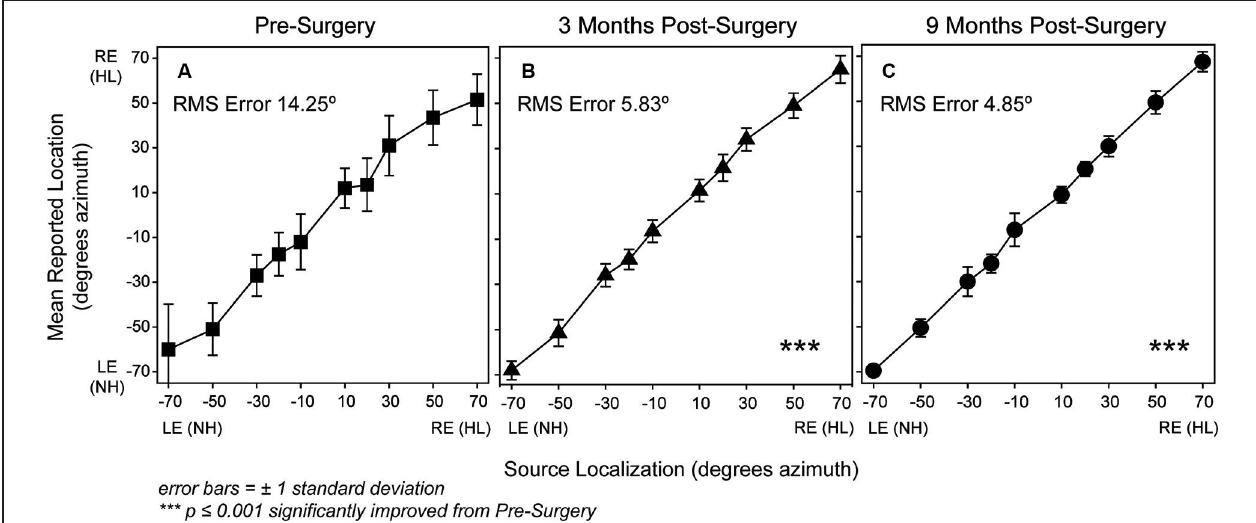
FIGURE 2 | P1’s localization responses are plotted for each test interval (Panel A, pre-surgery, square symbols; Panel B, 3 months post-surgery, triangle symbols; Panel C, 9 months post-surgery, circle symbols) . The x -axis shows the sound-source loudspeaker locations in degrees azimuth that range from − 70 degrees toward the NH ear side at axis’ left to + 70 degrees toward the hearing-impaired ear side at the axis’ right. The y -axis shows the possible reported response loudspeaker locations in degrees azimuth that